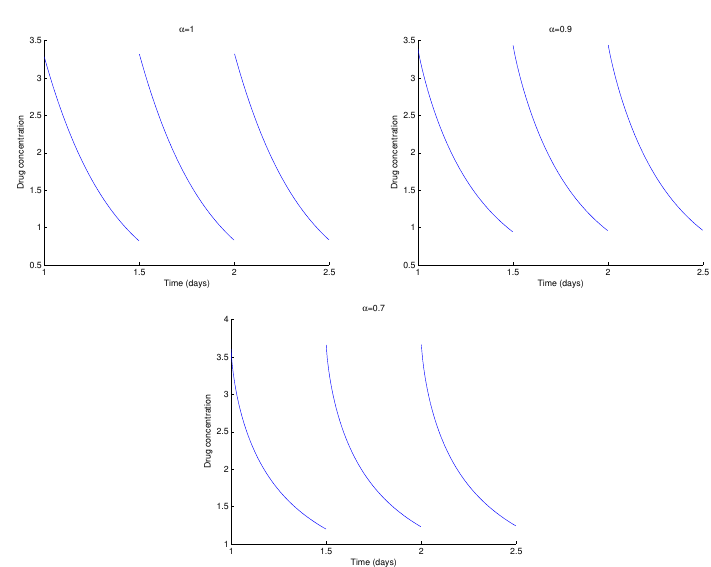
Figure 3. Drug concentration in the plasma, R , given by system (1) for α = 1 ( top left ), α = 0.9 ( top right ) and α = 0.7 ( bottom ). Parameter values and initial conditions in the text.